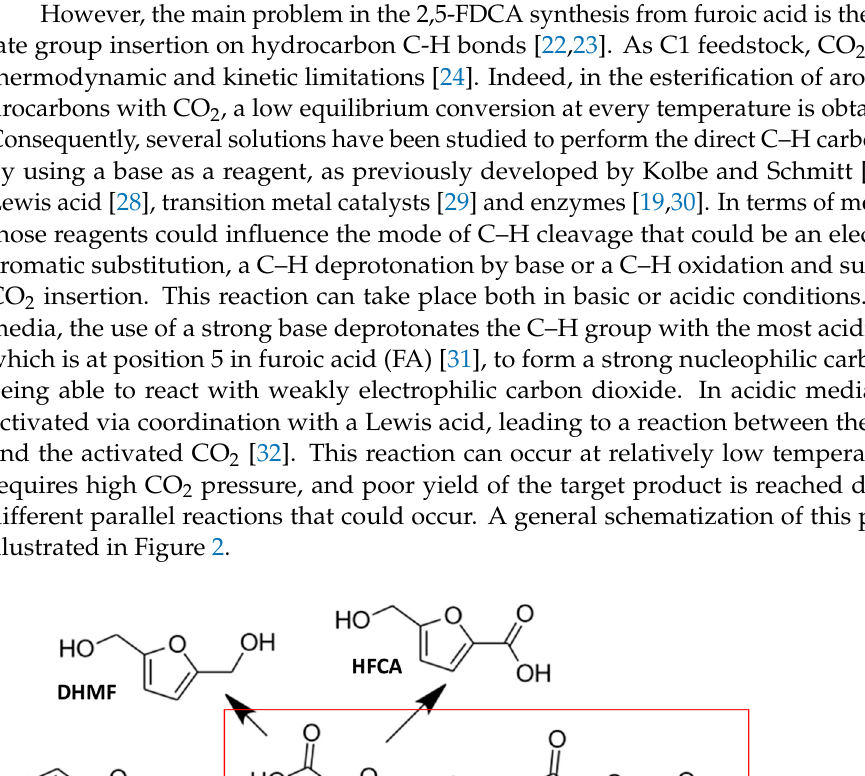
Figure 1. Reactional scheme of CO 2 carboxylation of furoic acid to 2,5-furandicarboxylic acid (2,5-FDCA).